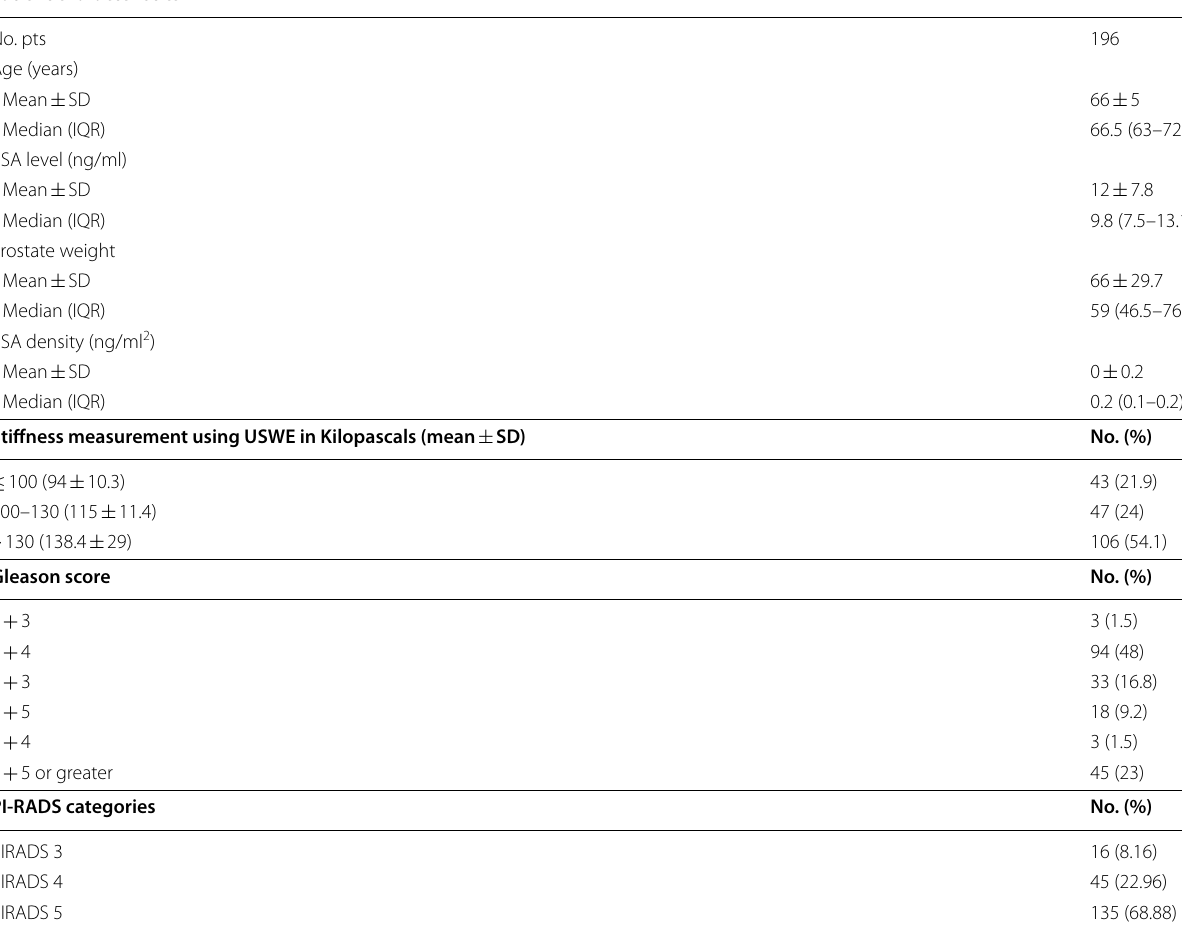
Table 1 Patient and imaging characteristics Patient